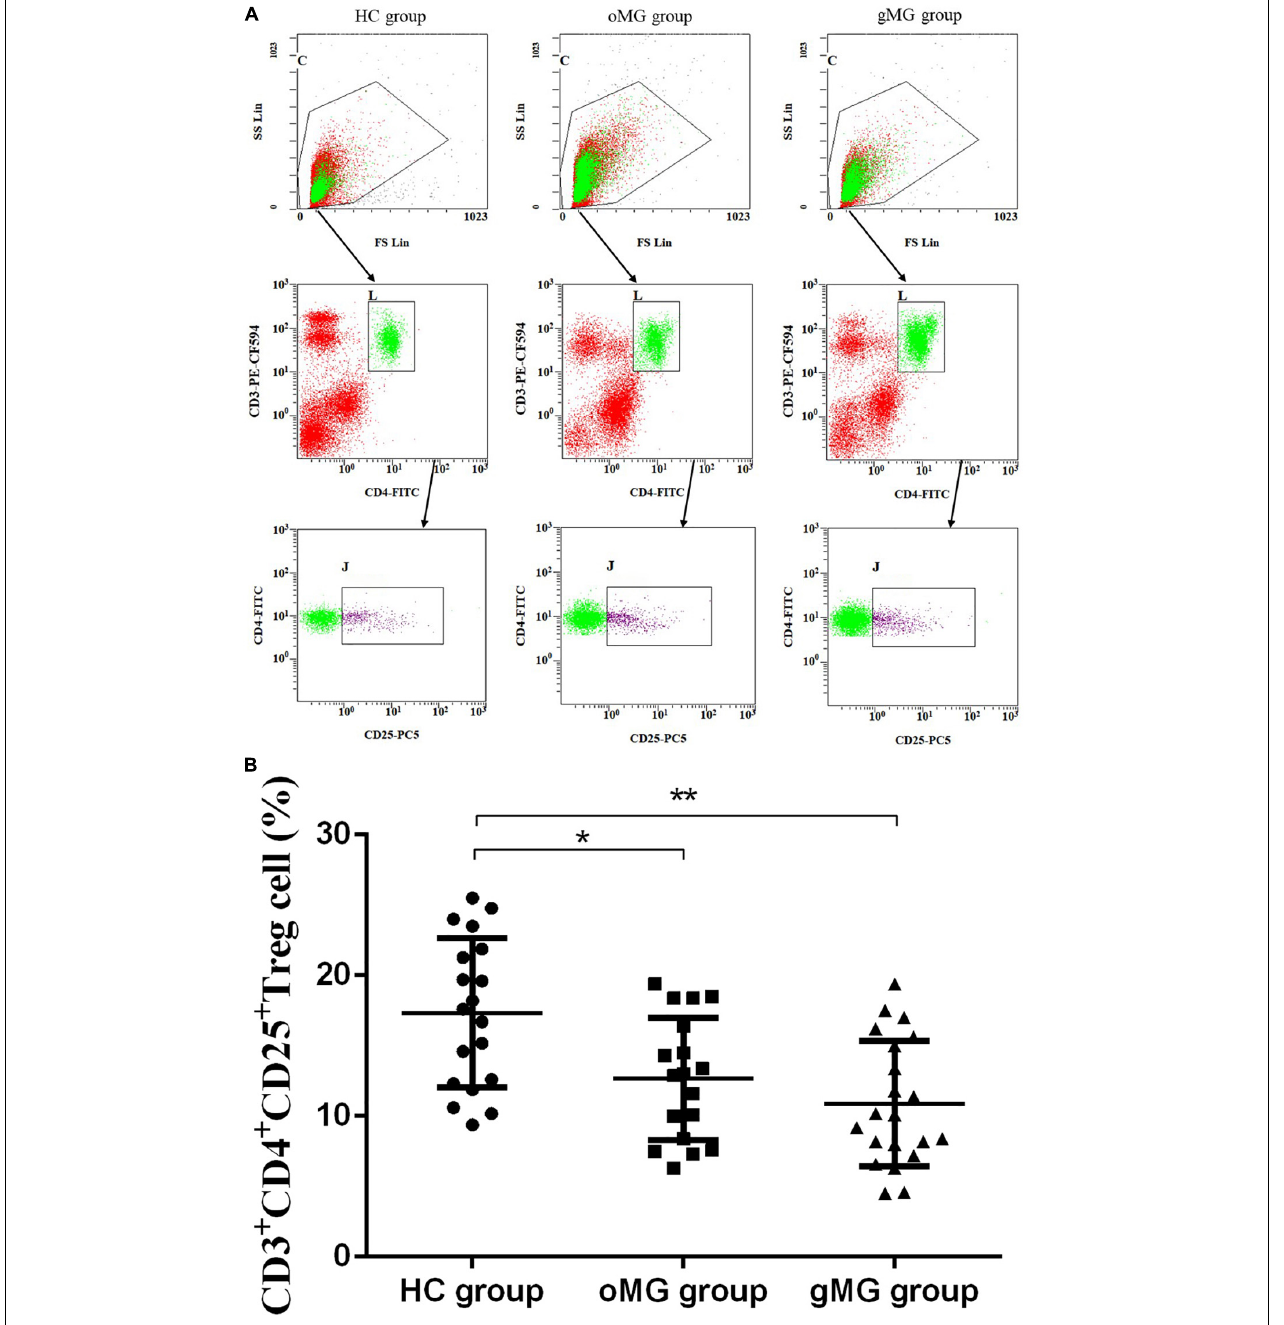
FIGURE 1 | Different expression of CD3 + CD4 + CD25 + Treg cells in peripheral blood of MG patients (oMG: n = 18, gMG: n = 21) and HCs ( n = 19). (A) Representative flow cytometry plots of CD3 + CD4 + CD25 + Treg cells in MG patients and HCs. (B) Comparison of the frequency of CD3 + CD4 + CD25 + Treg cells between MG patients and HCs. The results are expressed as the Mean ± SD of three independent experiments (* p < 0.05, ** p <